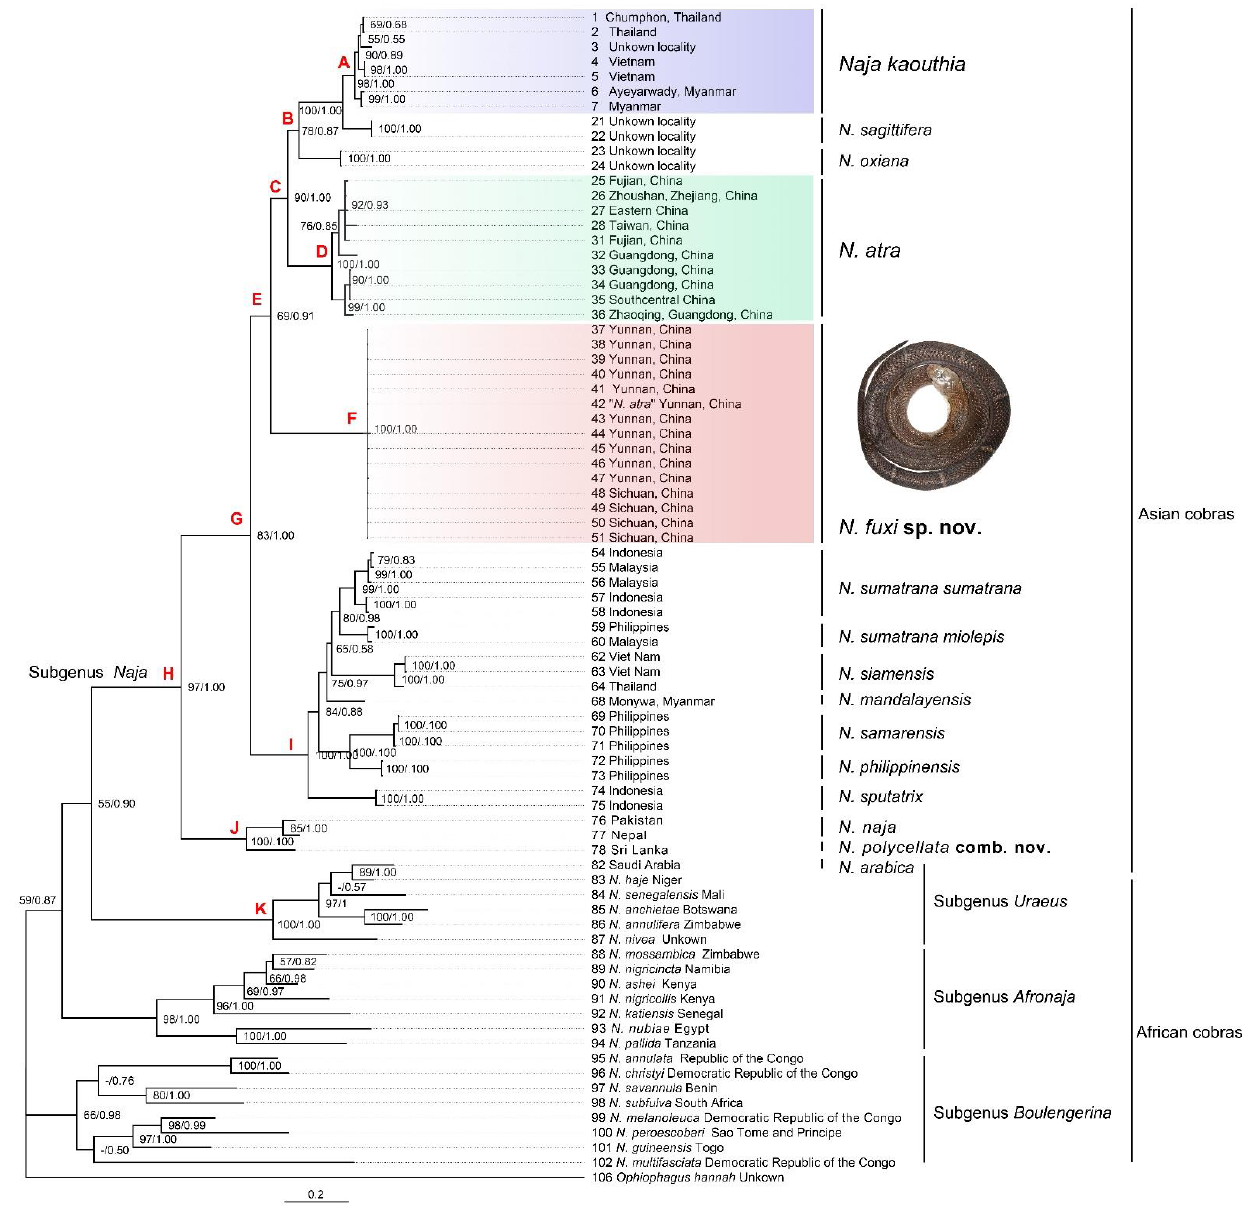
Figure 2. Phylogenetic trees of the genus Naja inferred by Bayesian analyses (BI) based on concatenated mitochondrial gene alignment for 1028 bp cyt b and 659 bp ND4. Both bootstrap supports (BS) and Bayesian posterior probabilities (BPP) are indicated on each of the corresponding node. Support values for weekly supported (BS < 50, BPP < 0.50) nodes are indicated as “ - ”. The COI alignment was 627 bp in length and contained ten taxa of Naja . The BI and ML analysis resulted in essentially identical topologies (Figure 3). The N. kaouthia from South Asia (India and Bangladesh) formed a clade (L; 99/1.00), which formed a larger clade (M; 57/0.94) with Southeastern Asian clade (A; 98/0.98). The “ N. kaouthia ” samples from Southwestern China formed a clade paraphyletic to the south and Southeastern N. kaouthia clade (M) and N. atra clade (D).